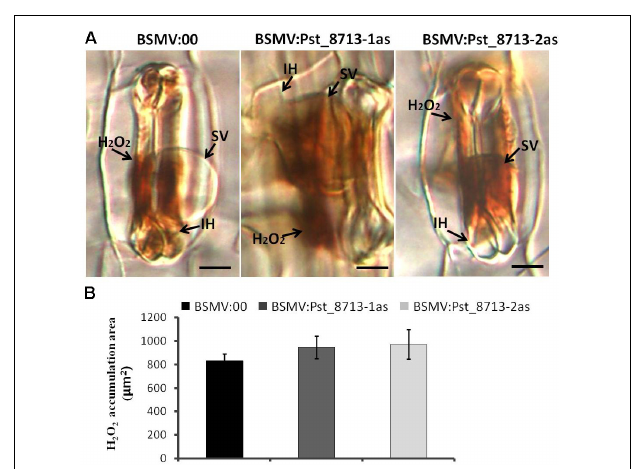
FIGURE 10 | Histological observation of host response in wheat plants inoculated first with BSMV:00 or recombinant BSMV, then with isolate CYR32. (A) H 2 O 2 accumulation in BSMV silenced leaves at 18 h after Pst inoculation. The fungal structure was stained with DAB and observed under differential interference contrast optics. Bars = 10 µ m. (B) Statistics of H 2 O 2 accumulation. The H 2 O 2 accumulation area were calculated using DP-BSW software (unit in × 10 3 / µ m 2 ). All bars indicated means ± SE of three independent biological replicates with 50 unit areas per replicate.